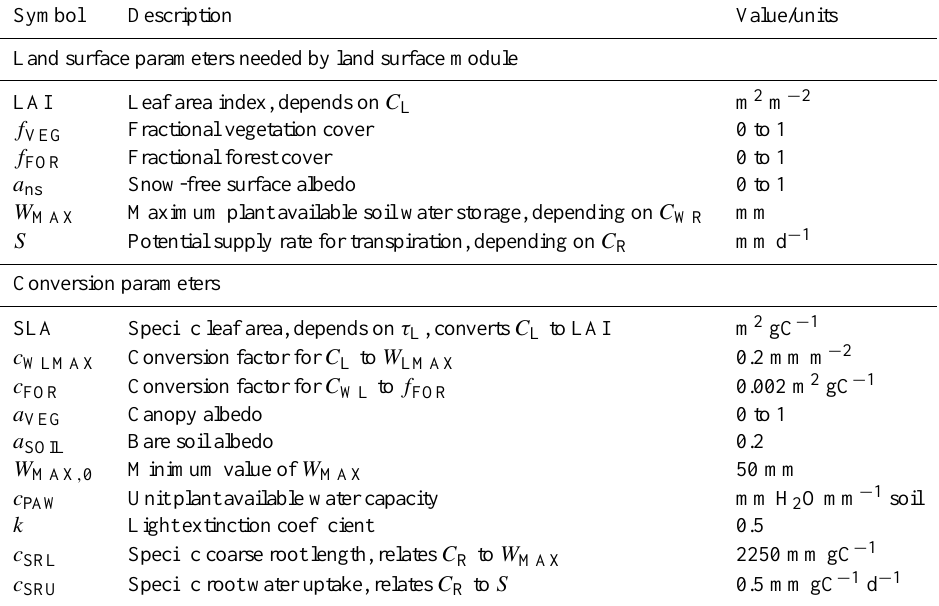
Table C3. Parameters and state variables of the interface between the land surface module and the plant growth